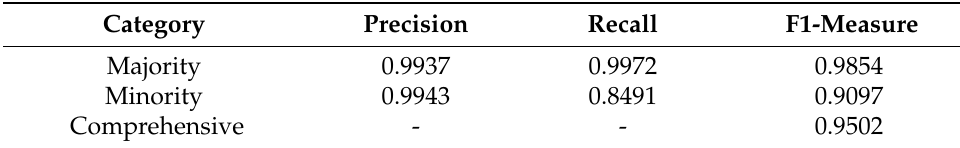
Figure 8. Tuning results of AdaBoost before optimization. Table 5. AdaBoost performance before optimization.